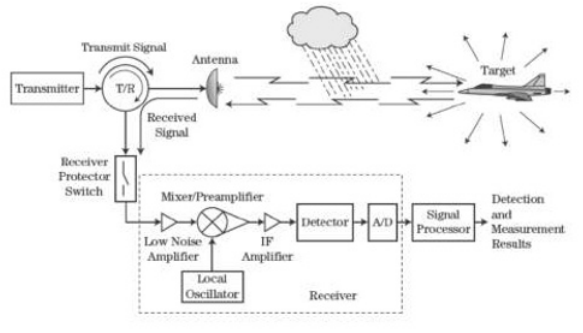
Figure 1. Basic elements of a radar including a target and atmo- spheric factors [2]